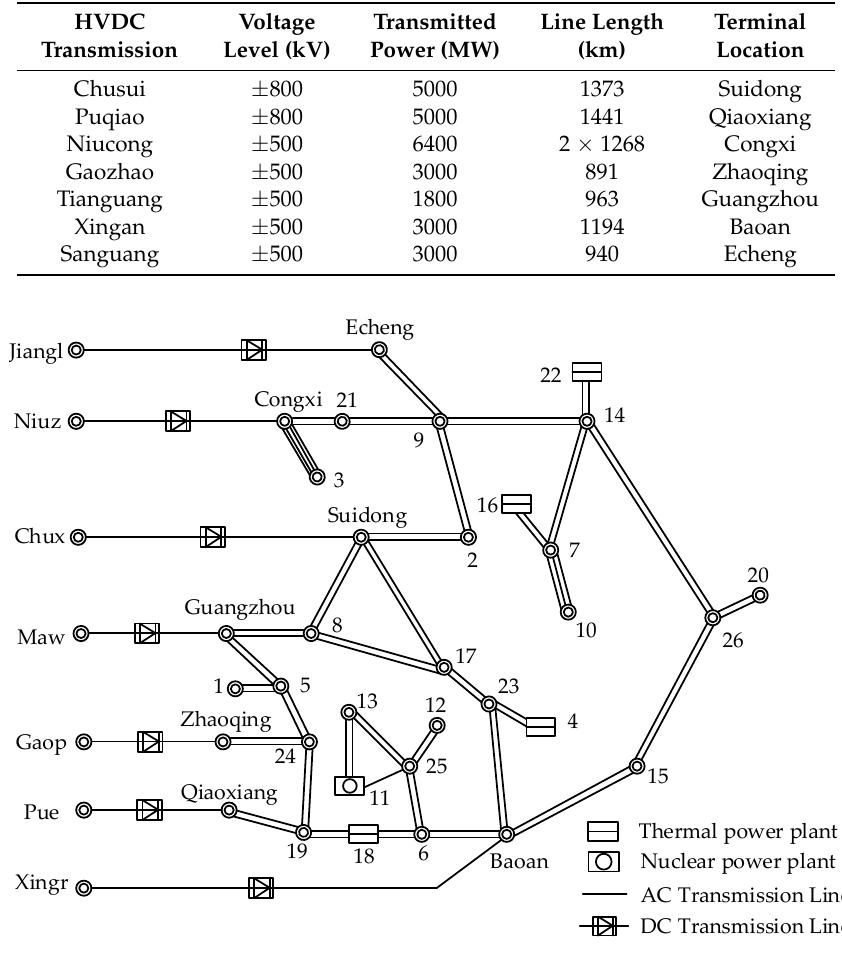
Figure 10. Sketch map of multi-infeed HVDC system in Guangdong grid in 2017.